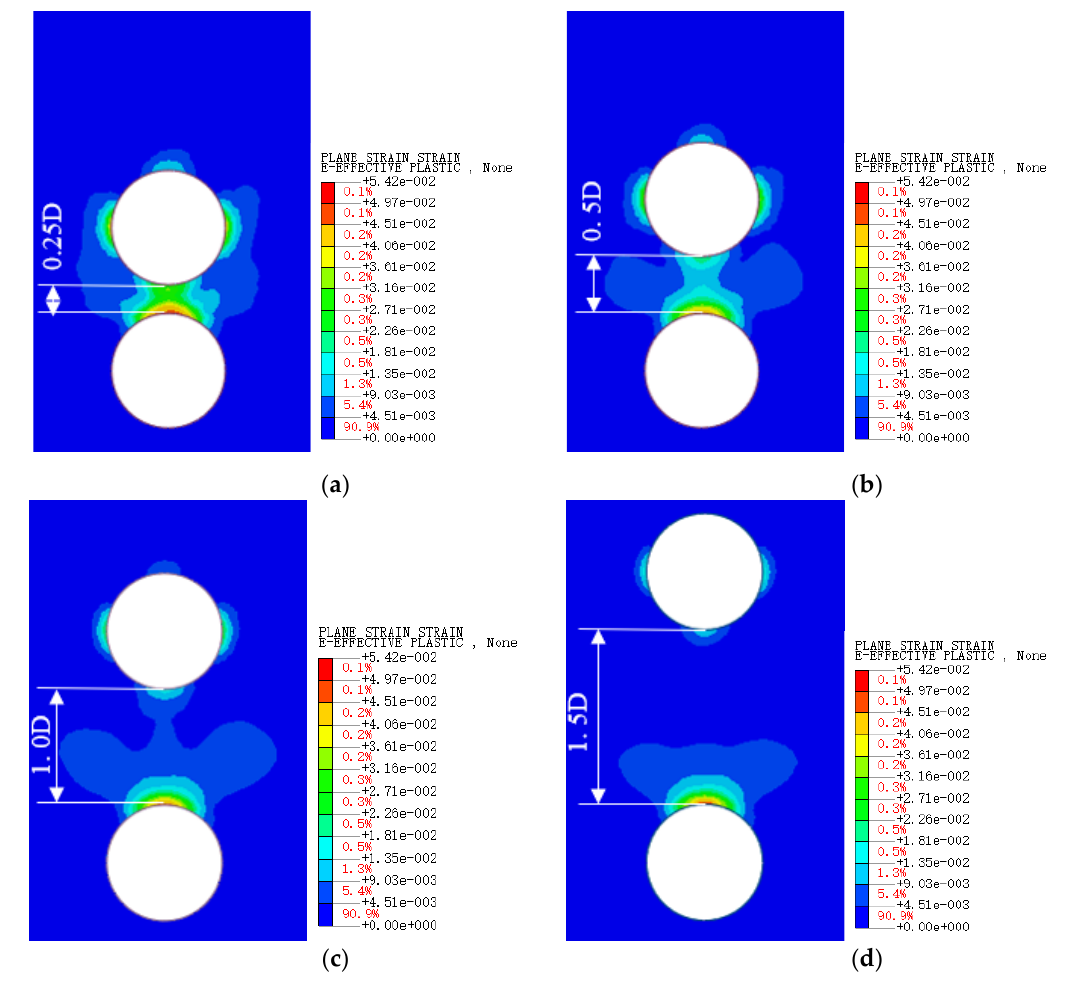
Figure 10. Effective plastic strain distribution of soil between vertical double layer pipe jacking with different thickness of soil interlayer: ( a ) 0.25 D; ( b ) 0.5 D; ( c ) 1.0 D; ( d ) 1.5 D.